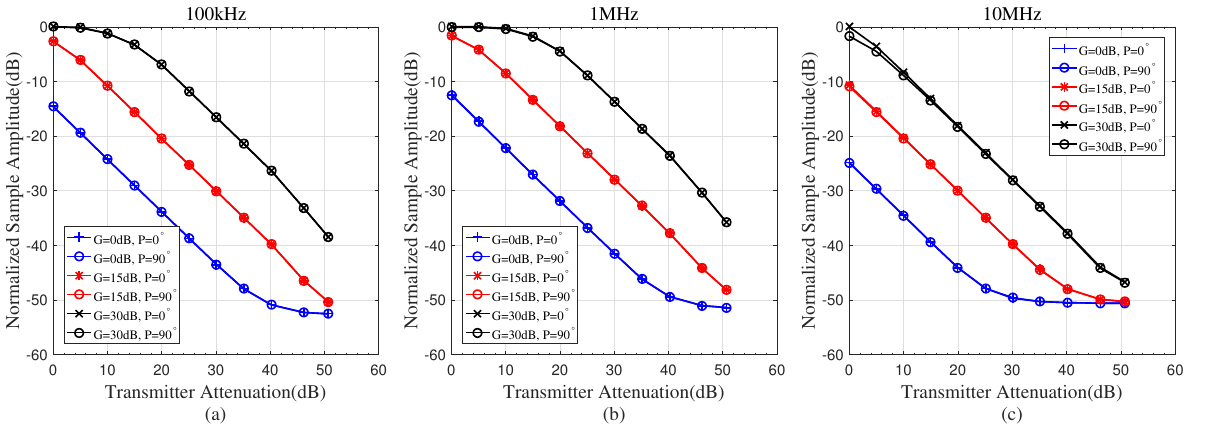
Figure 5. The normalized amplitudes of samples at different chain gains and transmitter phase shifts when the excitation signal frequency is ( a ) 100 kHz, ( b ) 1 MHz and ( c ) 10 MHz, respectively. G stands for the gain of receiving chain and P represents the phase of transmitted signal.